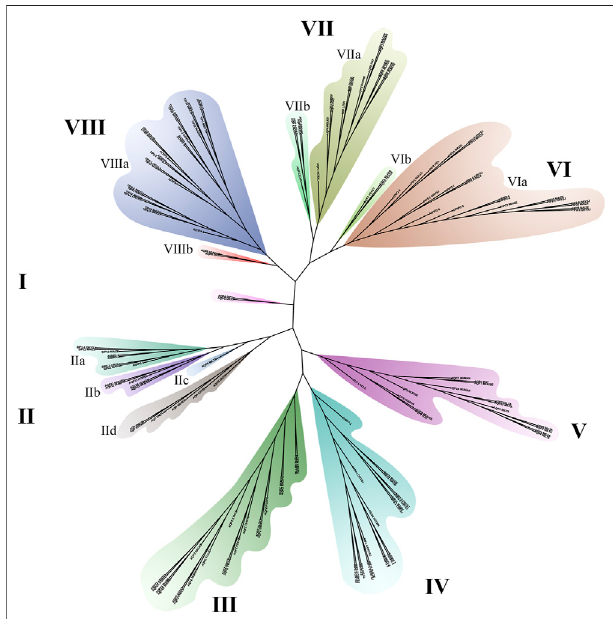
FIGURE 5 | Phylogenetic analysis of positive AQP